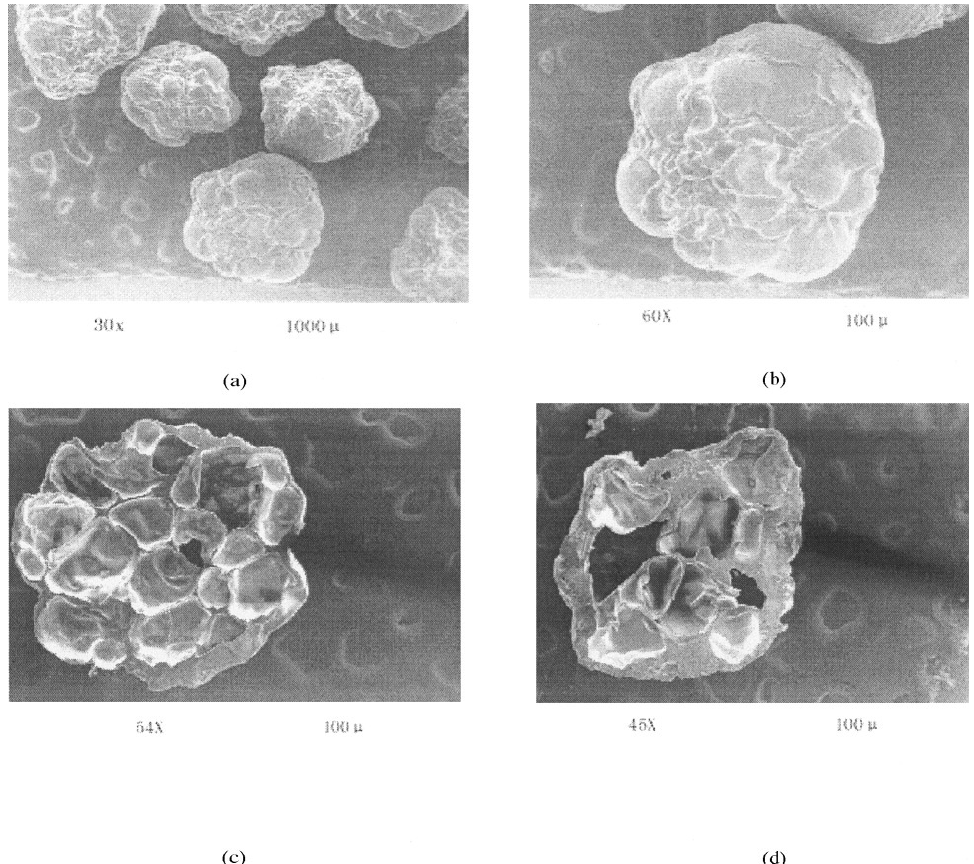
Figure 18. Schematic SEM micrographs of blank microspheres with microballoons inside: ( a , b ) photographs of FI [gelatin:xanthan gum 1:1], ( c ) cross-section photograph of FI, and ( d ) cross-section photograph of FIII [gelatin:xanthan gum 3:1]. Reproduced from [144] with permissions.